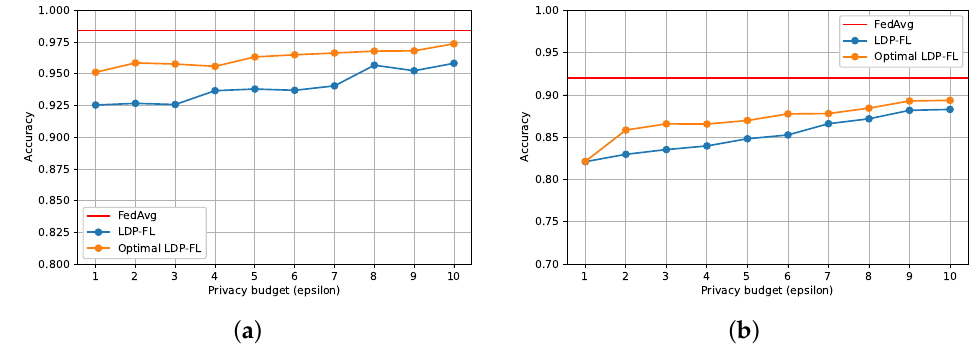
Figure 4. Model accuracy vs. privacy budget for different federated learning frameworks on MNIST and Fashion MNIST datasets: ( a ) MNIST and ( b ) Fashion